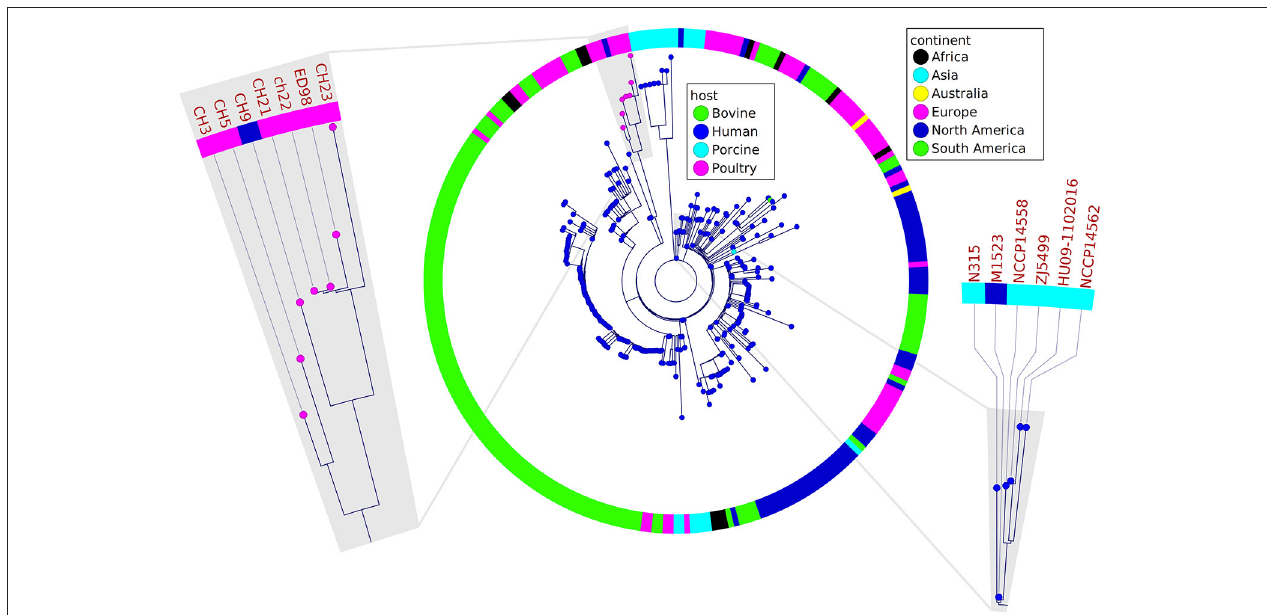
FIGURE 2 | Phylogenetic relatedness of analyzed poultry strains to a representative group of other strains belonging to ST5 group determined by the analysis of 97 different loci, 44kb of sequence in total. The poultry-associated strains comprise a distinctive phylogenetic group. Markedly, CH21 and ch22 strains are indistinguishable. Fragments of the tree containing reference strains ED98 and N315 for poultry- and human-origin strains, respectively, are magnified.